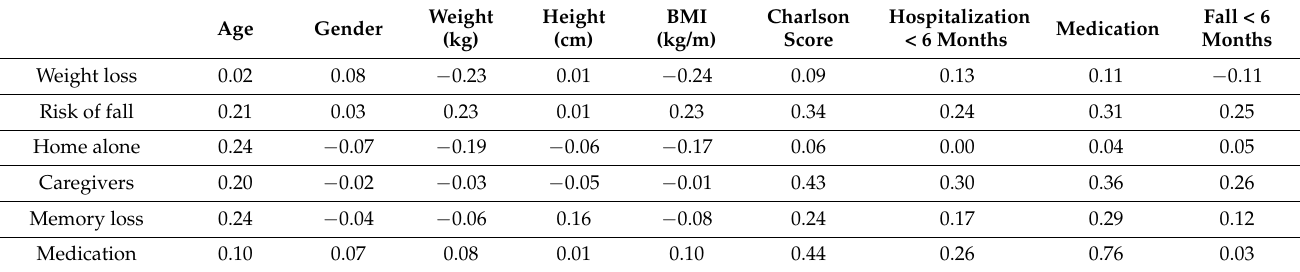
Table 6. Correlation